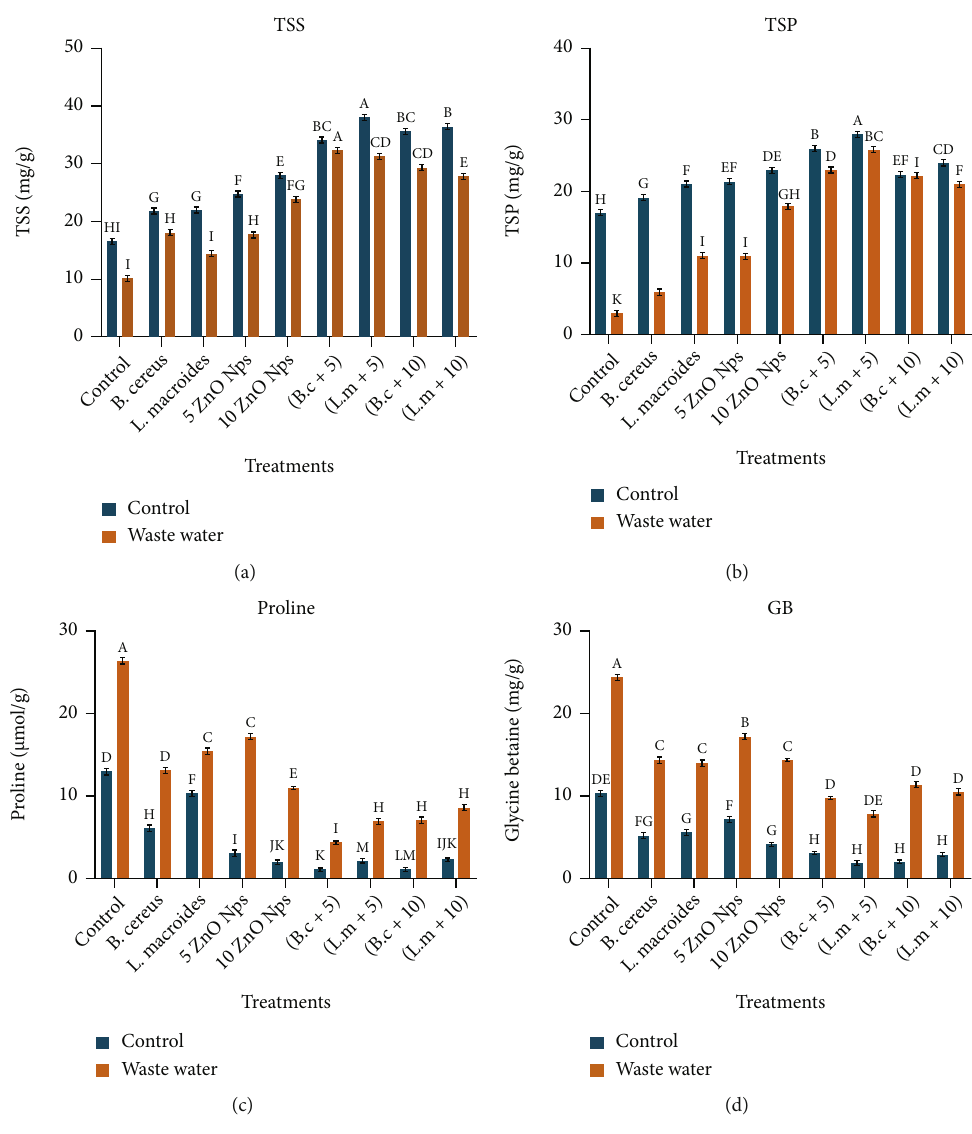
Figure 6: Synergistic e ff ect of bacteria strains ( Bacillus cereus and Lysinibacillus macroides ) and ZnO NP (5 mg/L and 10mg/L) treatments on (a) total soluble sugar, (b) total soluble protein, (c) total proline, and (d) glycine betaine content of rice grown in heavy metal- contaminated water. Error bars showed means of standard error ( ± SE) of three replicates ( n = 3 ) followed by di ff erent alphabetic letters showing statistical signi fi cance at 5% probability level. Control (distilled water), B.C+5 ( Bacillus cereus +5 mg/L ZnO NPs), L.M+5 ( Lysinibacillus macroides +5mg/L ZnO NPs), B.C+10 ( Bacillus cereus +10mg/L ZnO NPs), and L.M+10 ( Lysinibacillus macroides +10 mg/L ZnO